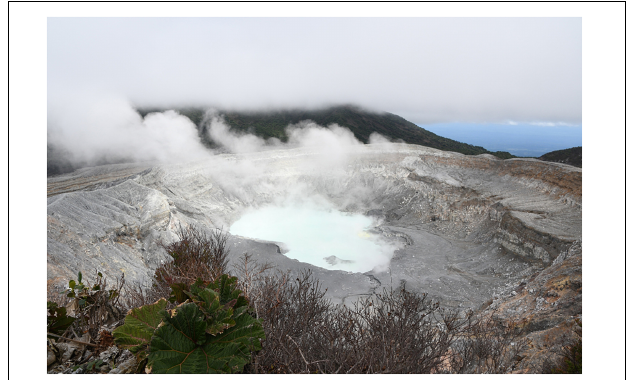
FIGURE 3 | Poas volcano crater and plants damaged by the volcanic activity, Costa Rica (photo by R.F. del